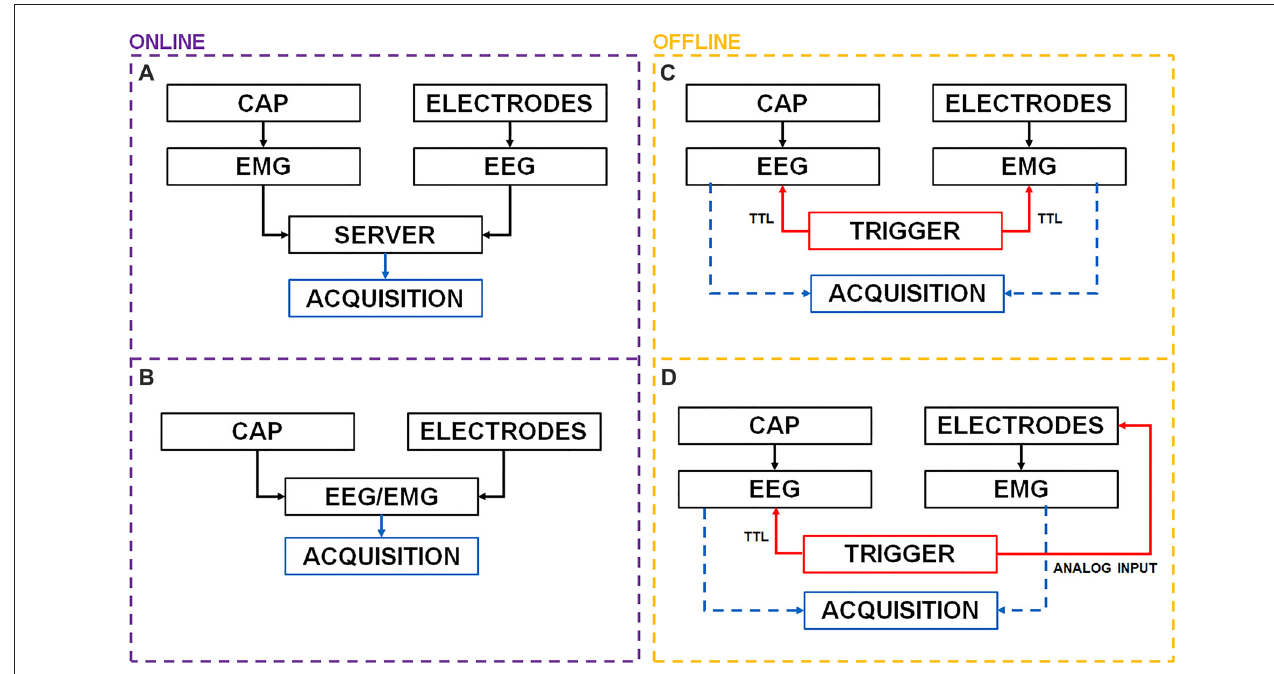
FIGURE 1 | Possible offline and online electroencephalogram (EEG) and electromyogram (EMG) synchronization architectures. (A) EEG and EMG data are pushed sample by sample or chunk by chunk to a server that timestamps and merges multiple streams. The server may then forward the data over a lab network or store it for offline use. (B) EEG electrodes are detached from their holder and used to record EMG data. Samples are automatically synchronized at collection time. (C) If both EEG and EMG amplifiers provide a Transistor-Transistor-Logic (TTL) port simultaneous digital pulses may be delivered to perform offline synchronization. (D) In case a TTL port is not available analog pulses may be directly delivered to an EMG electrode before and after the recording